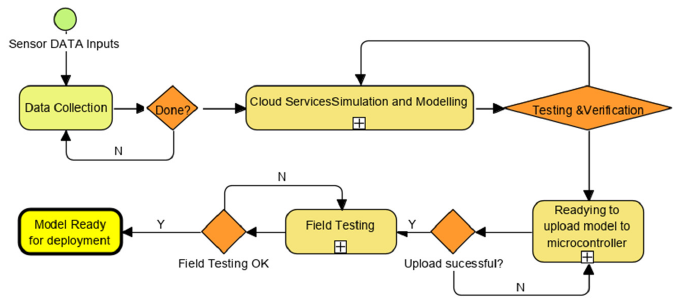
Figure 7. TinyML Process Workflow.